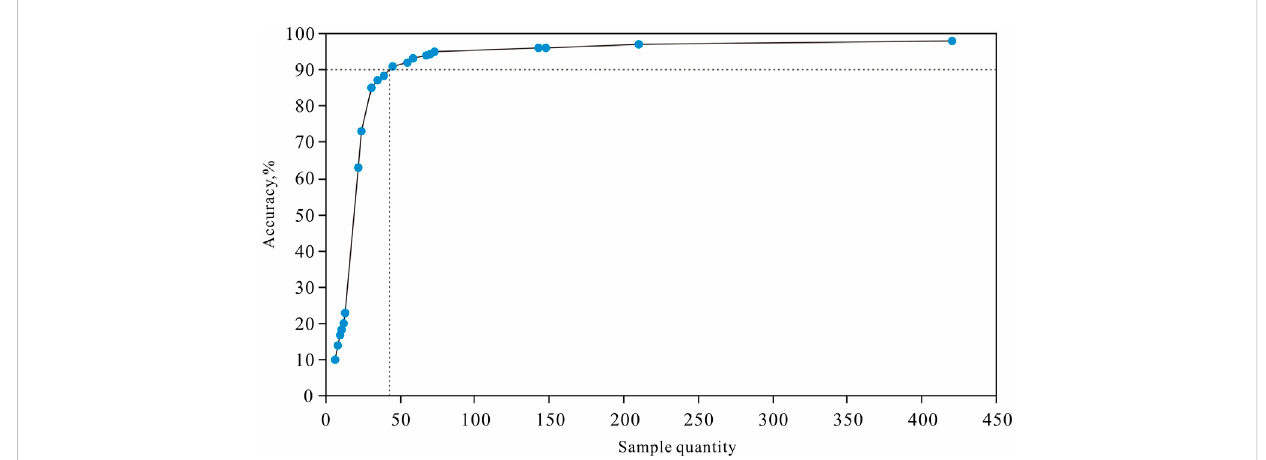
FIGURE 12 Relationship between learning sample quantity and forecast accuracy (statistics from model (a)).